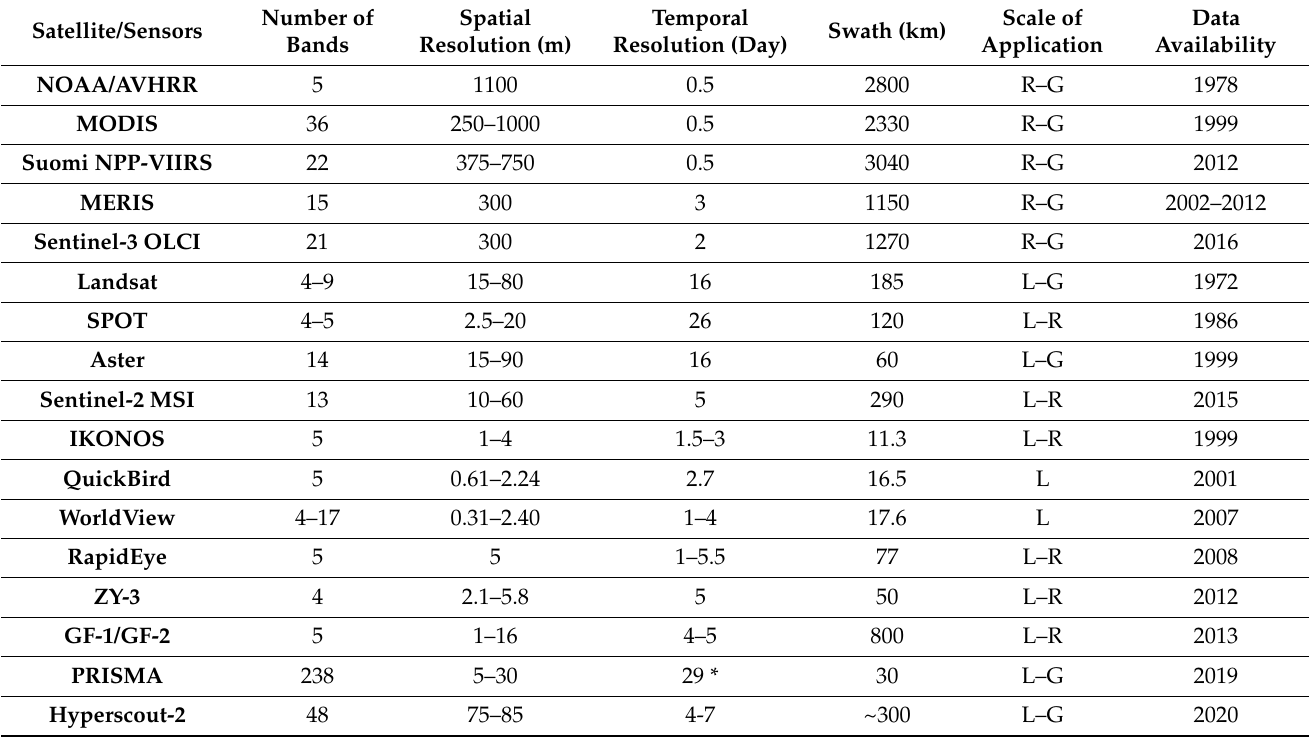
Table 2. List of optical sensors. Adapted from